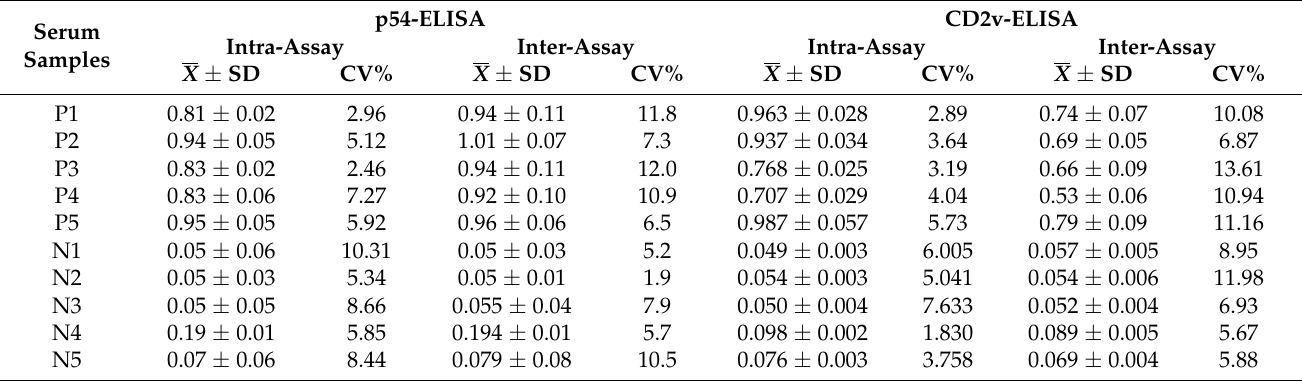
Table 2. Intra- and inter-assay repeatability test of the established